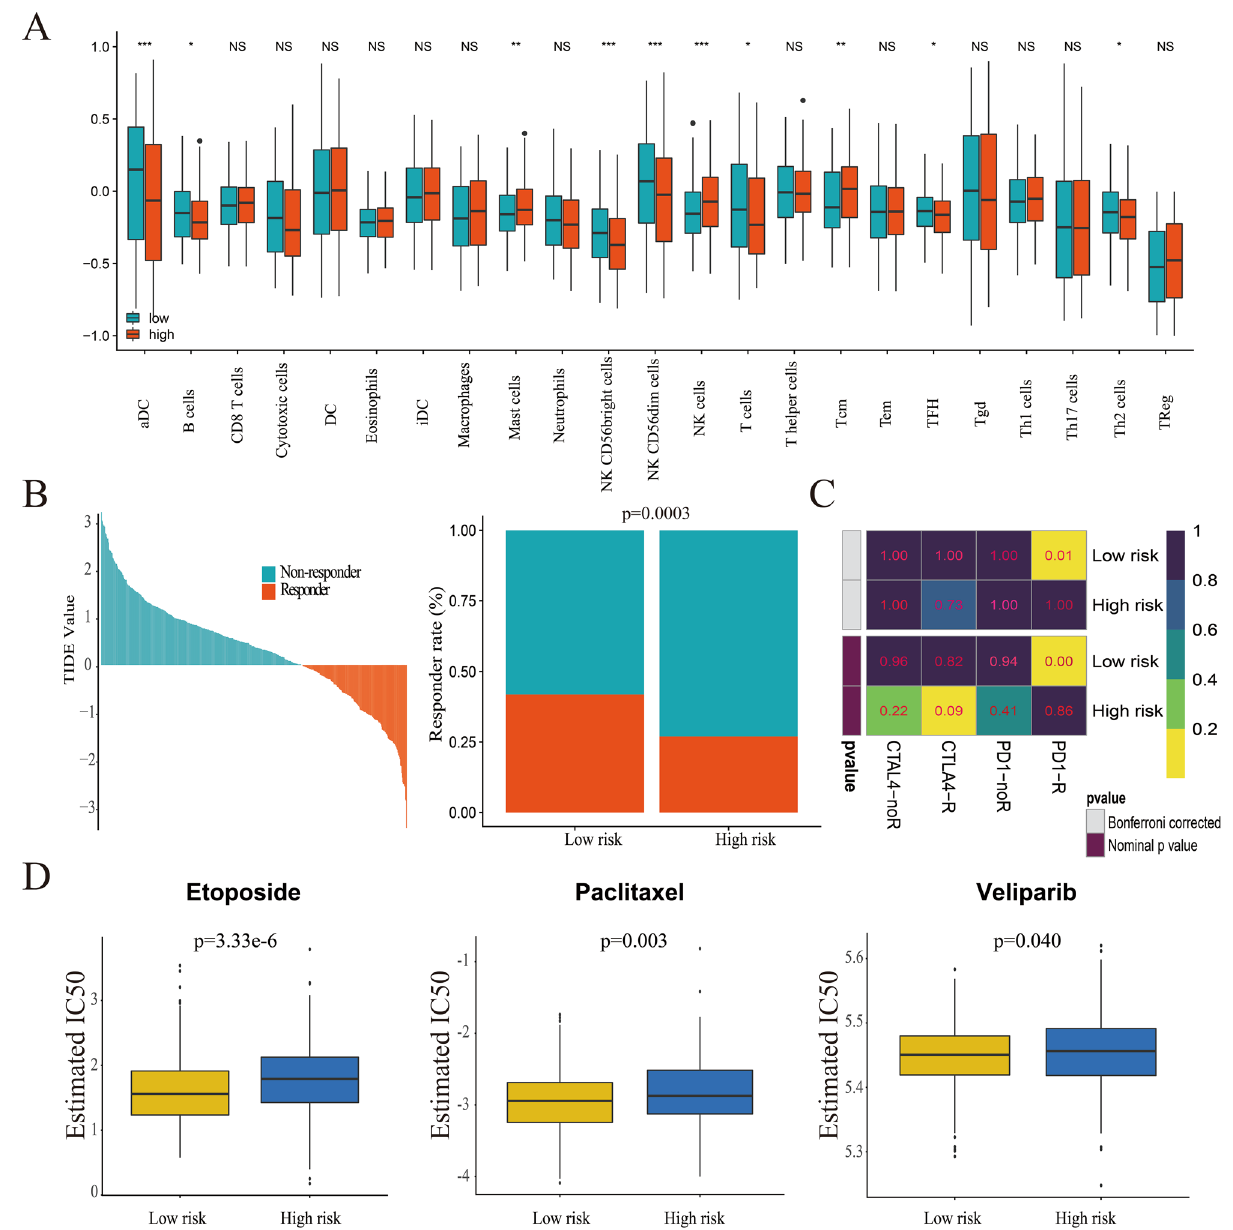
Figure 8. Difference between high-risk score group and low-risk score group in immune infiltration, immunotherapy and chemotherapy response prediction. ( A ) immune infiltration proportion of TIICs between high-risk score group and low-risk score group (* p < 0.05; ** p < 0.01; *** p < 0.001); ( B ) the TIDE value and response to immunotherapy of patients with SOC; ( C ) the response to anti-CTAL4 and anti-PD-1 therapy of patients with SOC in both groups; ( D ) Estimated IC50 values indicate the efficiency of chemotherapy by etoposide, paclitaxel and veliparib in both CBX5 was identified as a potential target in regulating lung cancer survival and the stem-like properties of lung CD133 + -tumor stem-like cells (TSLCs) 29 . It was reported that BRD4 suppression enhanced the cytotoxicity of CHK1 inhibition in HGSOC, which was mediated by the increased expression of CBX5 30 . The CREB3 marker was identified as an oncogene that plays an important role in tumor metastasis in various cancers; including prostate cancer, breast cancer, and osteosarcoma 31–33 . It is reported that the CREB3 antigen may serve as an effective biomarker with high diagnostic sensitivity and specificity in OC, although its prognostic role is unclear 34 . The FOXK2 and FOXJ1 are members of the forkhead box (FOX) transcription factors. Growing evidence shows that FOXK2 participates in a range of key processes in cancer cells, such as cell proliferation, invasion and migration, DNA damage, and autophagy 35 . The function of FOXK2 is context and tumor-specific, and it might serve as an oncogene and tumor suppressor in different cancers 36 . It was reported that FOXK2 inhibited cell proliferation and invasion in breast cancer, non-small cell lung cancer (NSCLC), clear-cell renal cell carcinoma, gastric cancer,